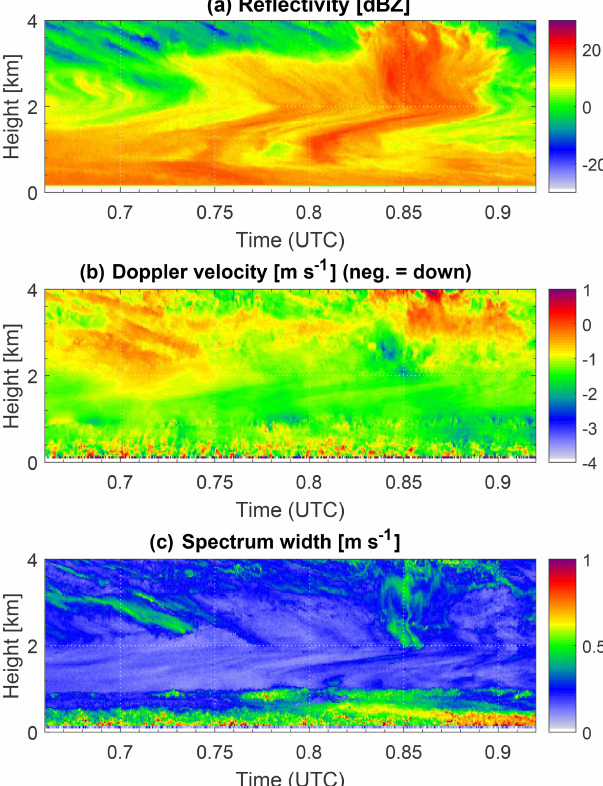
Figure A1. Like Fig. 4 but for 16 February 2014, 0.67–0.92UTC, at 0–4km